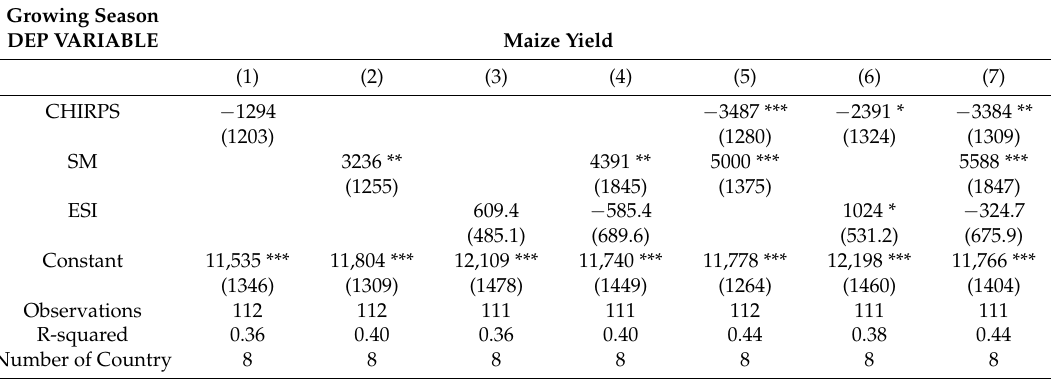
Table 3. Results of the simple linear regression with fixed effects focusing on maize-growing months for standardized anomalies of rainfall (Column 1), soil moisture (Column 2), ESI (Column 3), soil moisture and ESI (Column 4), rainfall and soil moisture (Column 5), rainfall and ESI (Column 6), and all variables combined (Column 7); annual maize yield is the dependent variable; rows represent the regression coefficient for the three independent variables (rainfall, soil moisture, ESI), the regression constant, the number of observations, the R-squared, and the number of countries (8); asterisks mark statistically significant results.